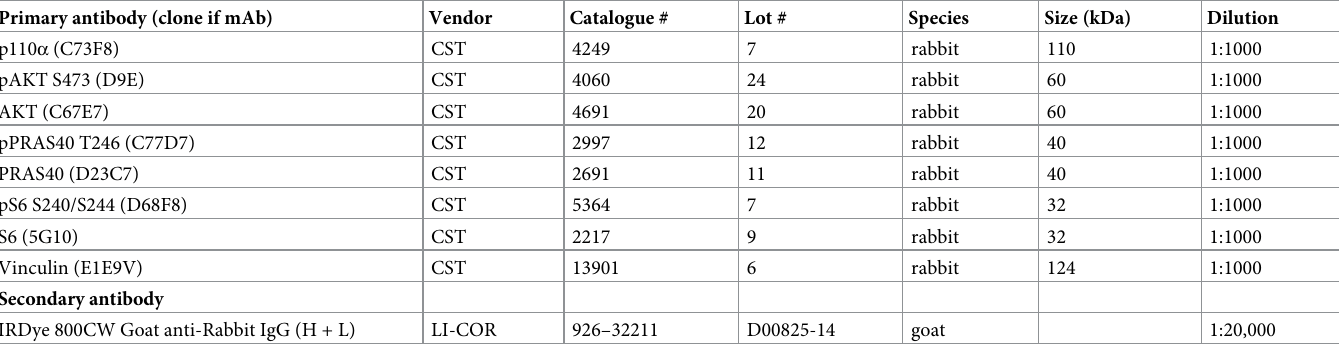
Table 2. Primary and secondary antibodies used for Western blotting. CST, Cell Signaling Technology. mAb, monoclonal antibody. Primary antibody (clone if